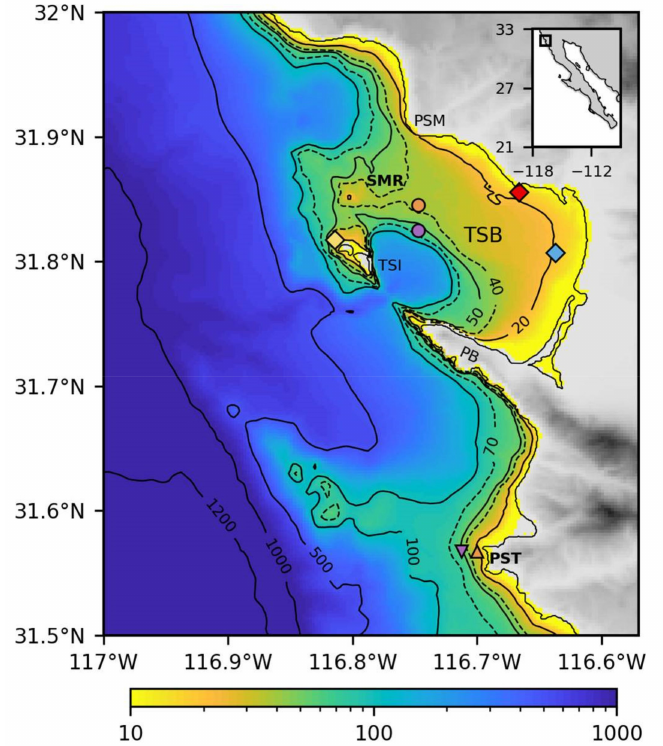
Figure 1. Bathymetry and location of the study area in the Baja California peninsula. The triangles and circles are the deep (purple) and shallow (orange) test sites in the hotspots areas of Punta Santo Tomas (PST) and San Miguel Reef (SMR), respectively. The diamonds are the ADCP measuring sites. The yellow diamond corresponds to ADCP 1, the red diamond to ADCP 2, and the blue diamond to ADCP 3. The text legends are Punta San Miguel (PSM), Todos Santos Bay (TSB), Todos Santos Islands (TBI), and Punta Banda (PB). The solid and dashed lines are the isobaths with values expressed in